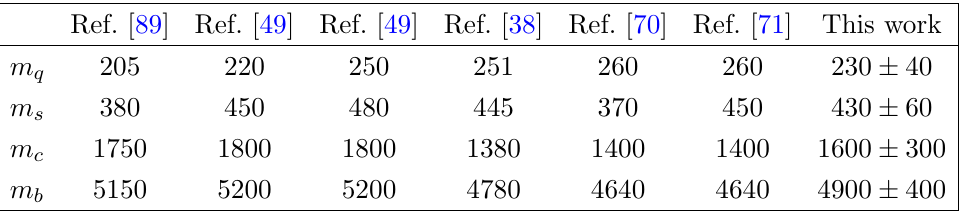
Table 1 . The values of quark masses (in units of MeV) suggested in the previous works and used in this work, where q = u; d . See text for explanation.